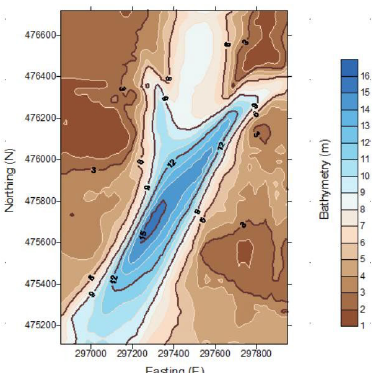
Figure 7. Bathymetric plan in 2D surface